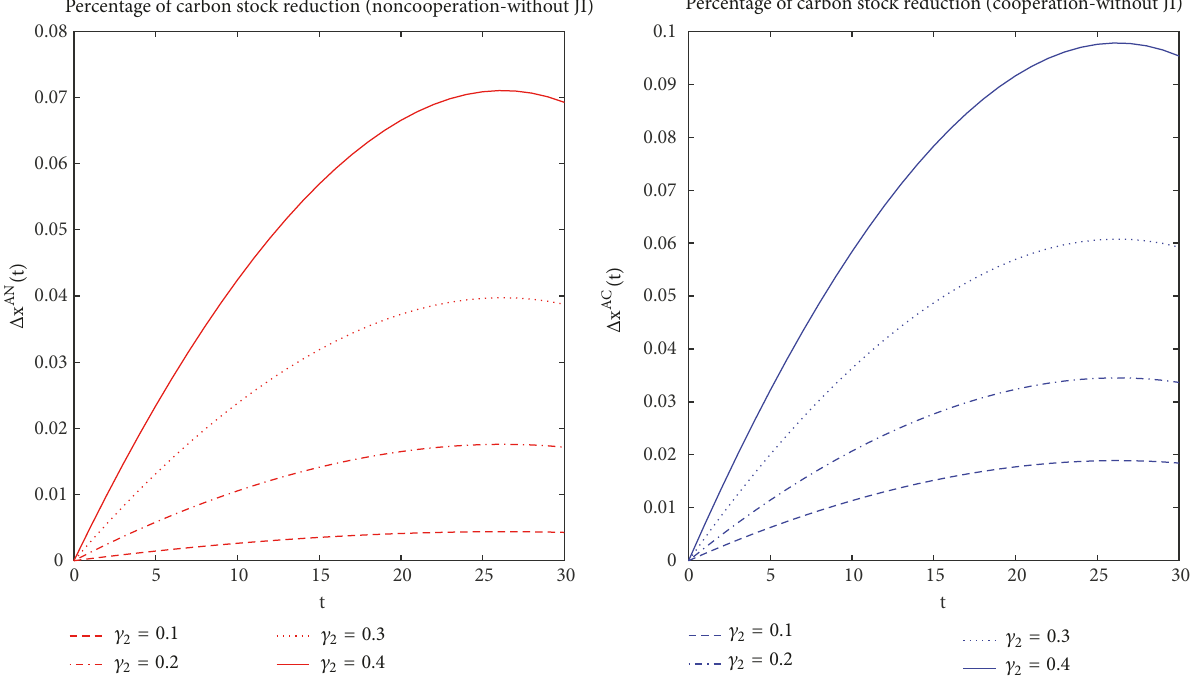
Figure 7: The behavior of percentage of carbon stock reduction as 𝛾 2